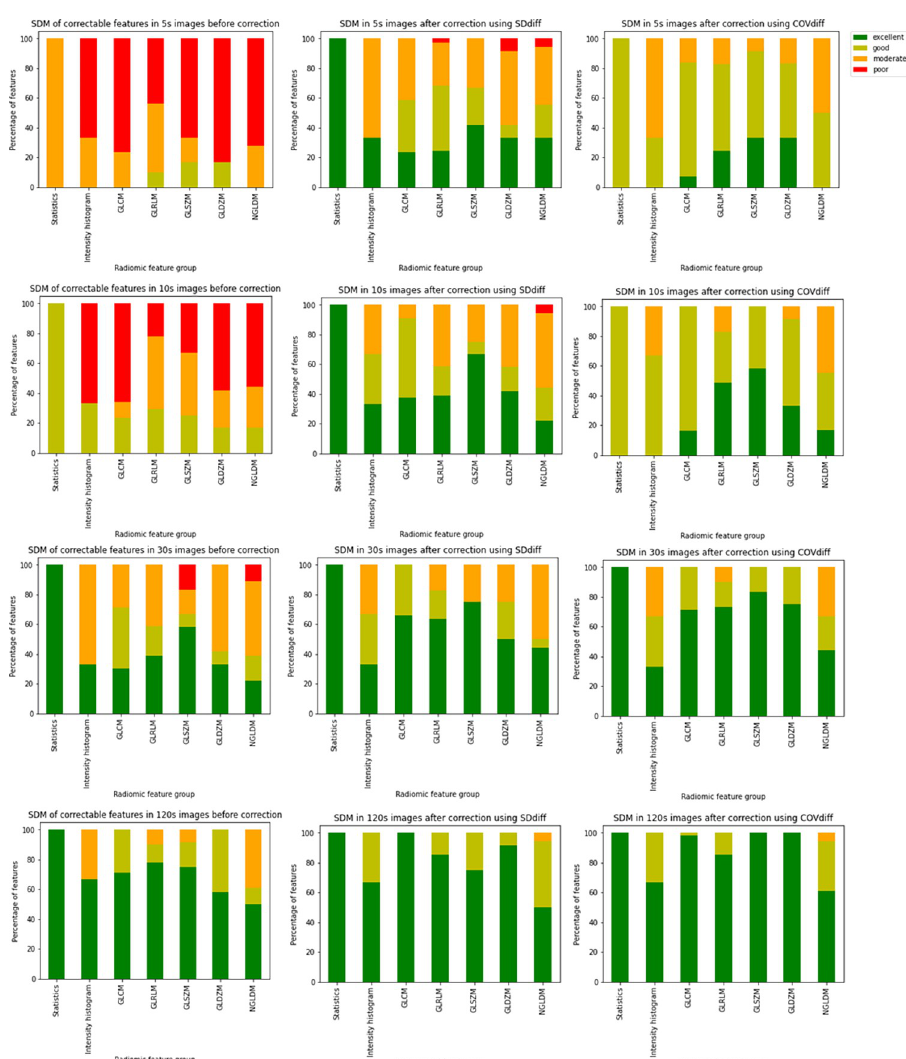
Fig 6. SDM of corrected features in EARL1 reconstructed images. From left to right: SDM before correction, SDM after correction using SD diff , and SDM after correction using COV diff . From top to bottom: SDM for different scan durations: 5 s, 10 s, 30 s, 120 s.